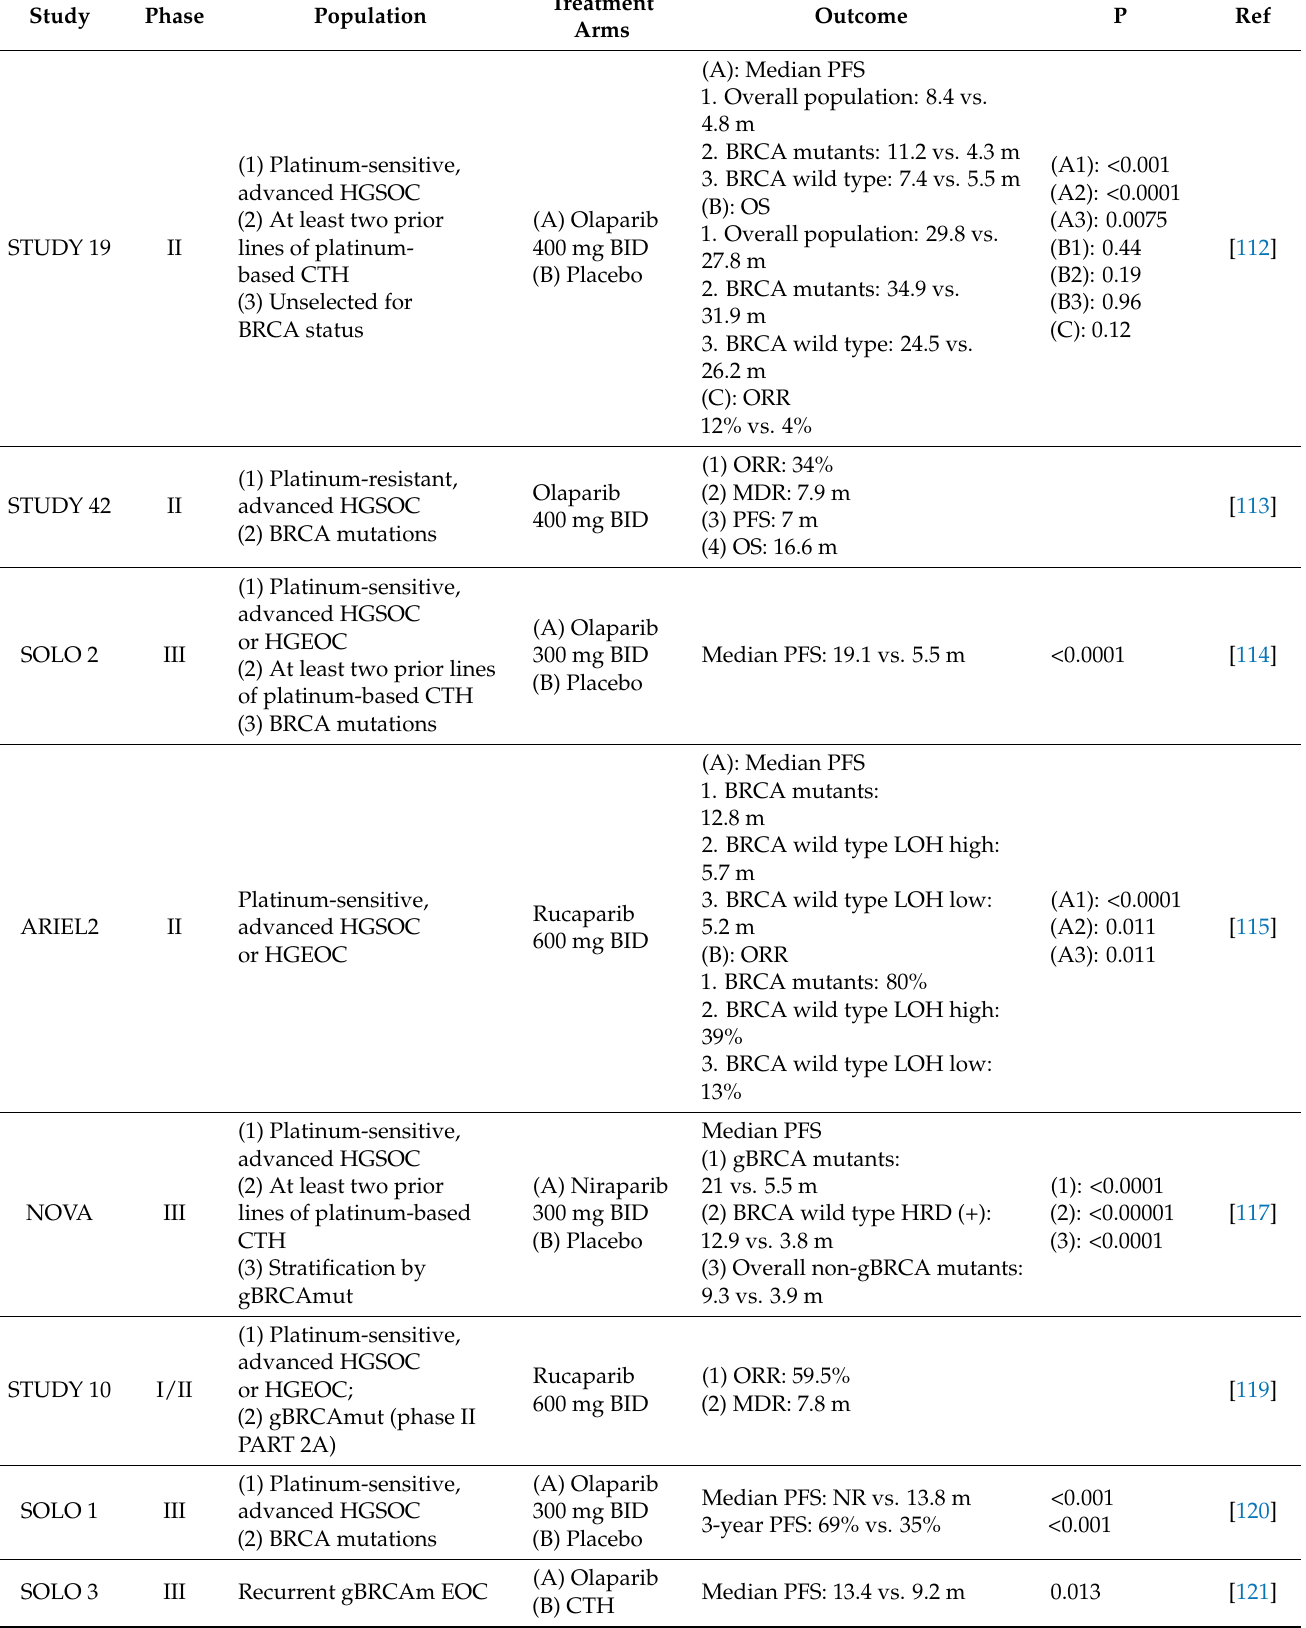
Table 1. Clinical trials of PARP inhibitors in ovarian